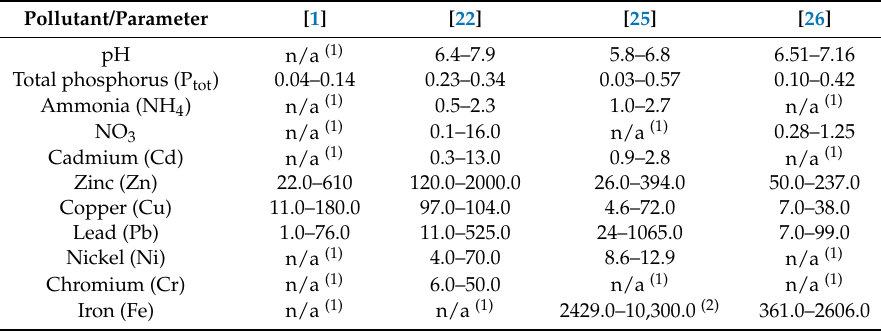
Table 2. Pollutants measured in stormwater runoff in the